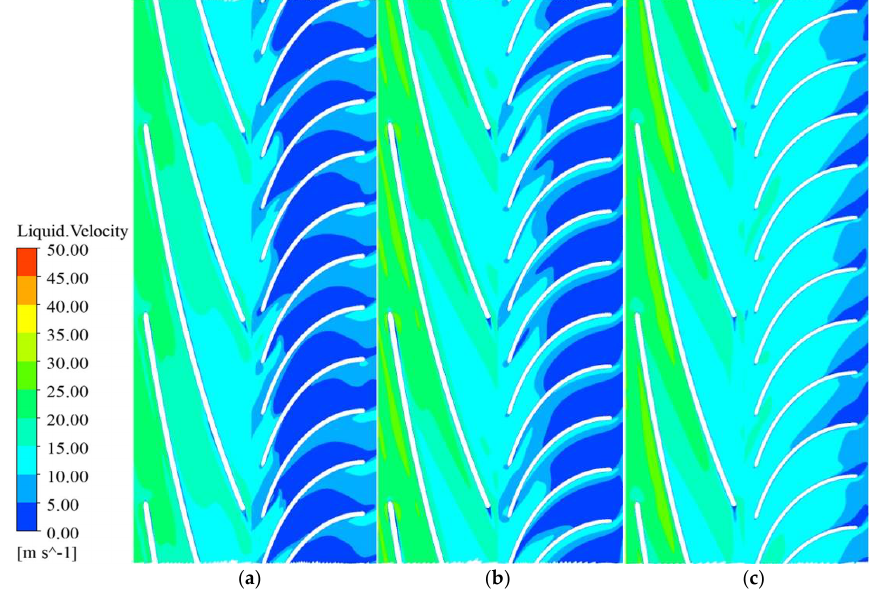
Figure 12. Velocity distribution in impeller and diffuser of different spans under GVF = 15%. ( a ) span = 0.1; ( b ) span = 0.5; ( c ) span = 0.9. ( a ) span = 0.1; ( b ) span = 0.5; ( c ) span =